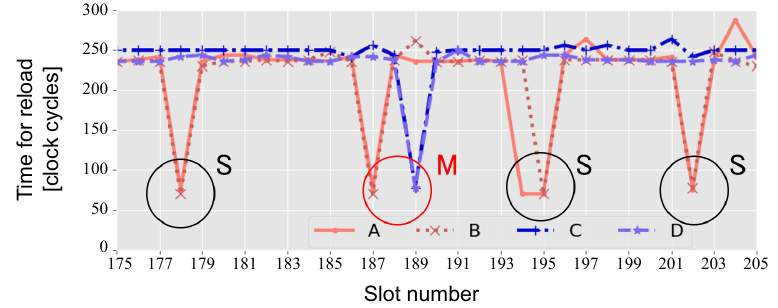
Figure 1: Example Flush+Reload